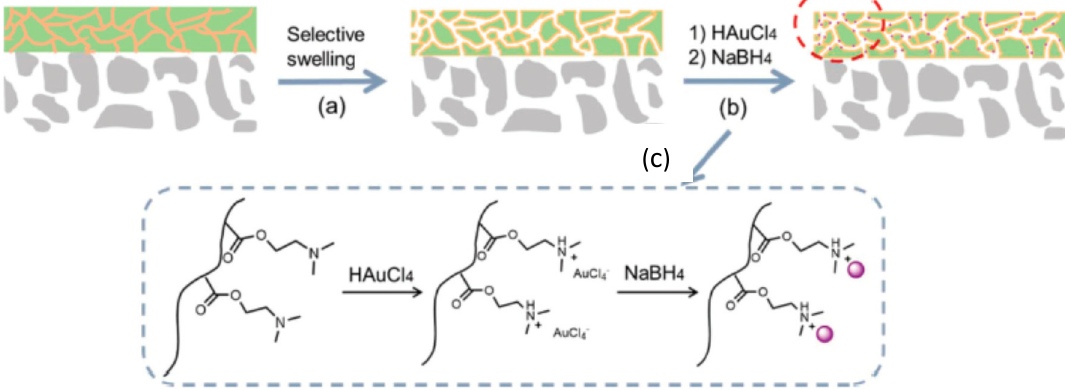
Figure 8. Selective swelling of PDMAEM- b -PS membrane ( a ), immobilization of gold nanoparticles on the surface of DMAEM- b -PS membrane ( b ), protonation of PDMAEM and reduction of [AuCl 4 ] − counterions to AuNPs ( c ). (Reproduced by permission of the Royal Society of Chemistry from [50]–Reproduced by permission of The Royal Society of Chemistry).